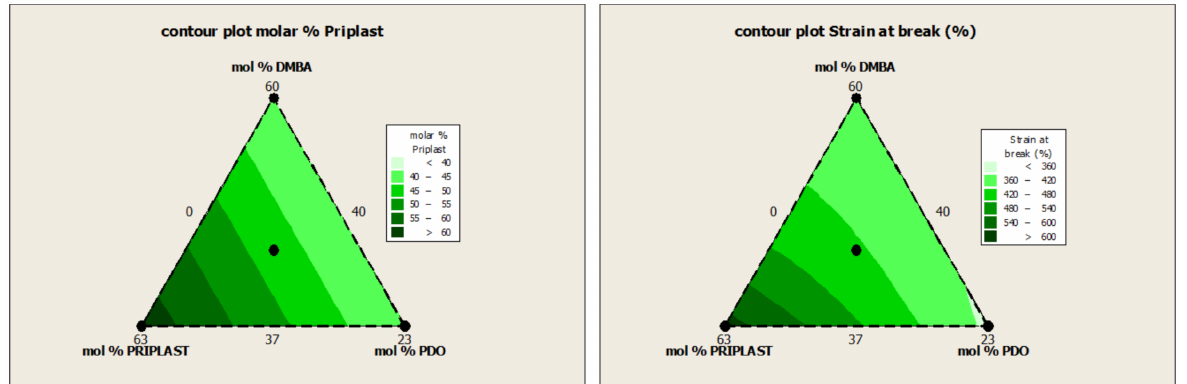
Figure 14. Contour plots obtained by Minitab software from the ternary mixture experimental design. ( Left ): contour plot of Priplast 3294 content in molar %. ( Right ): contour plot of ε b (strain at break). Water swelling of the films after 48 h at 25 ◦ C was assessed on all of the WPUD films, as well as the reference sample RD27 for comparison purposes. Figure 15 shows the water swelling values.